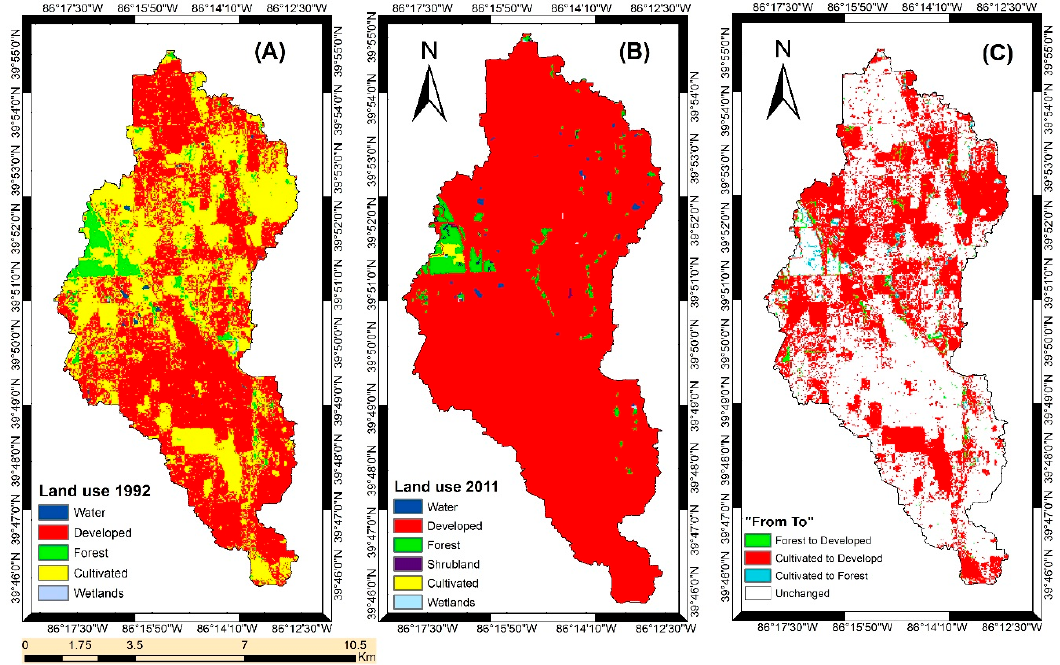
Figure 3. Land use types in LEC watershed in ( A ) 1992; ( B ) 2011 and ( C ) the transition between 1992 and 2011.